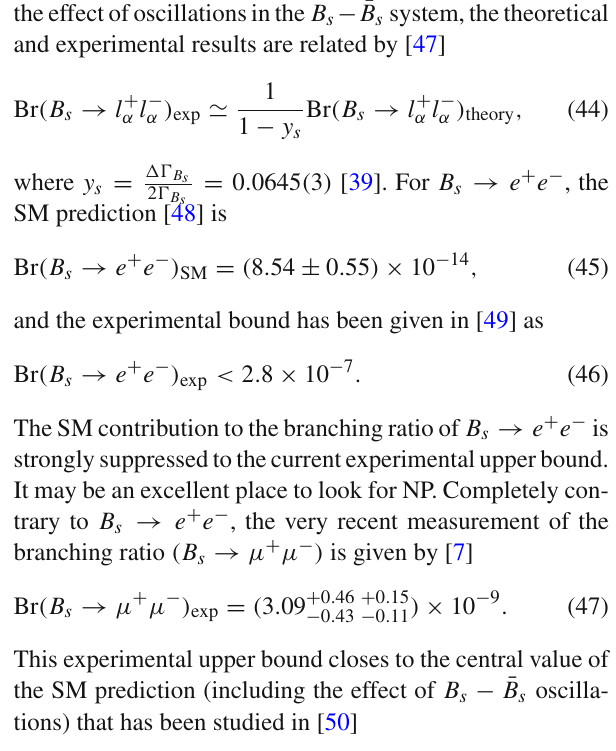
/(cid:3) m Z 2 , Z N on the NP scale w K , B s , B d K , B s , B d